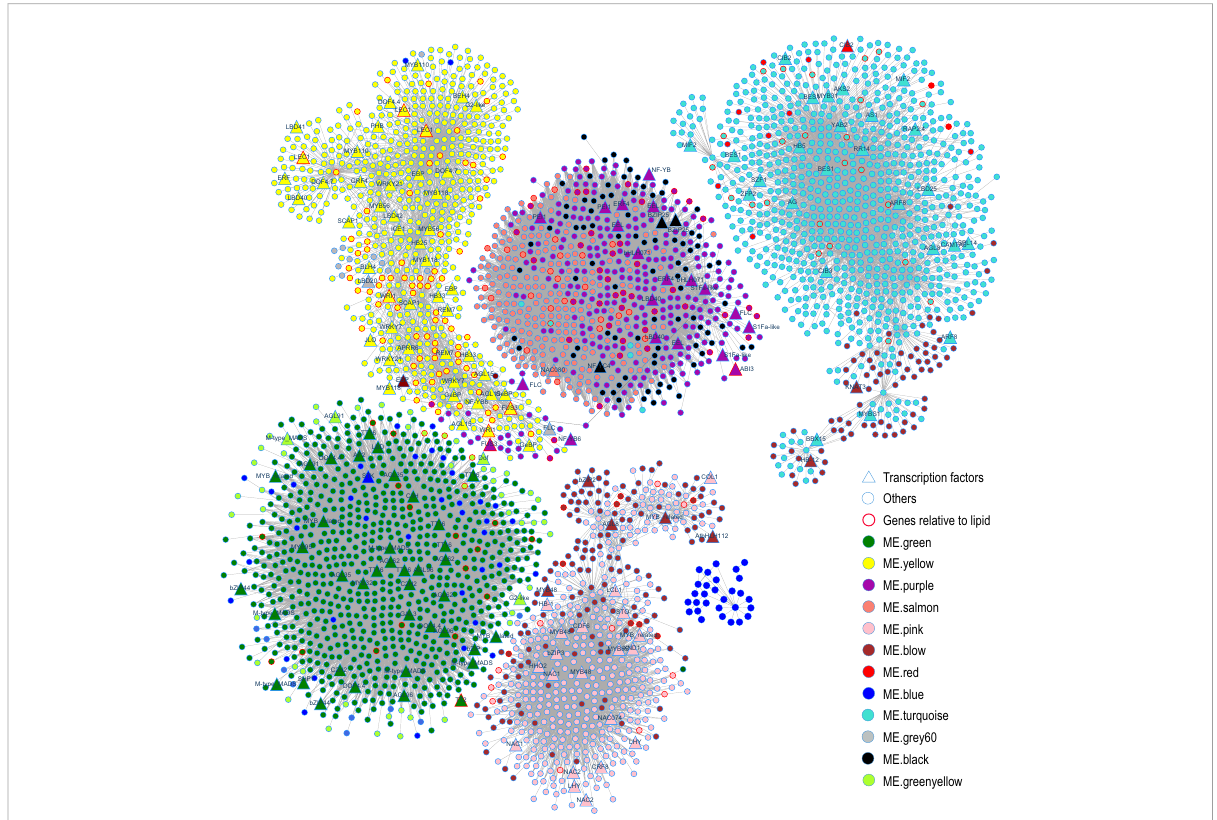
FIGURE 10 Coexpression network during silique development. Gene names of transcription factors were shown in the fi gure. And gene names are names of their A. thaliana homologs (Supplementary Table